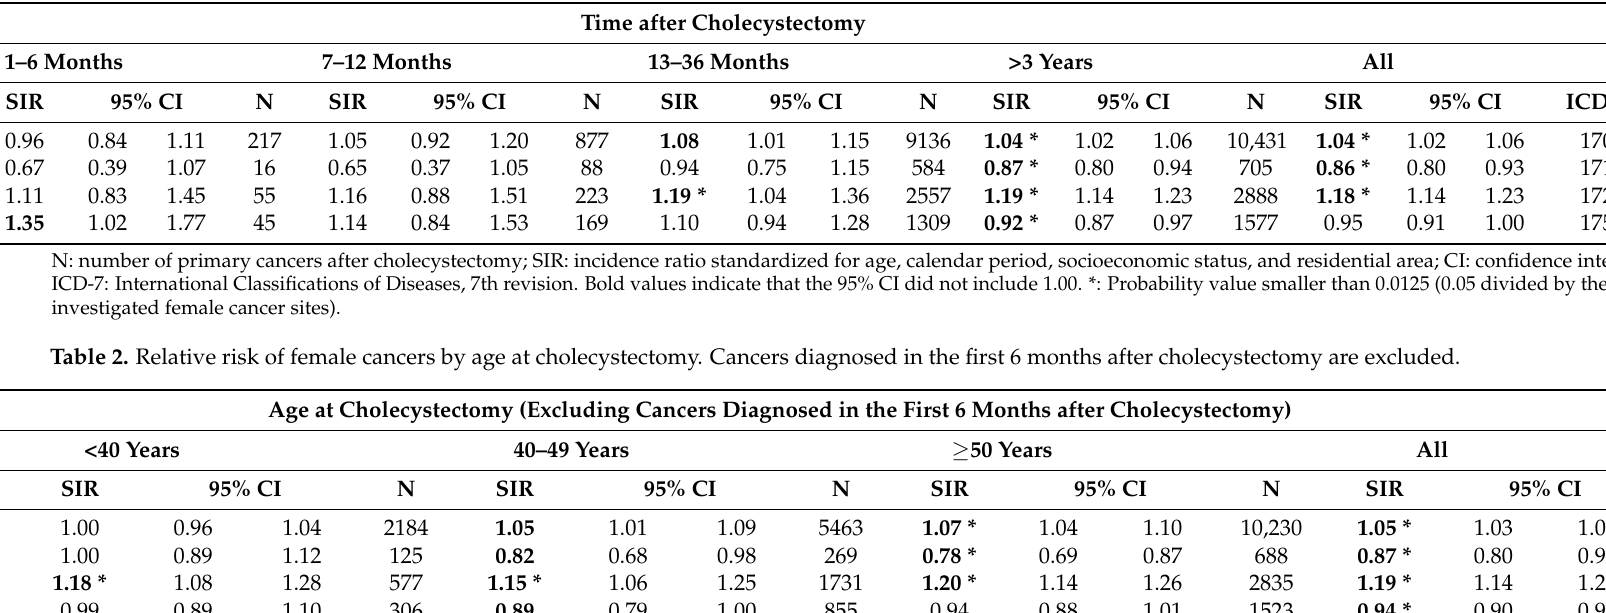
Table 1. Relative risk of female cancers by time after cholecystectomy.